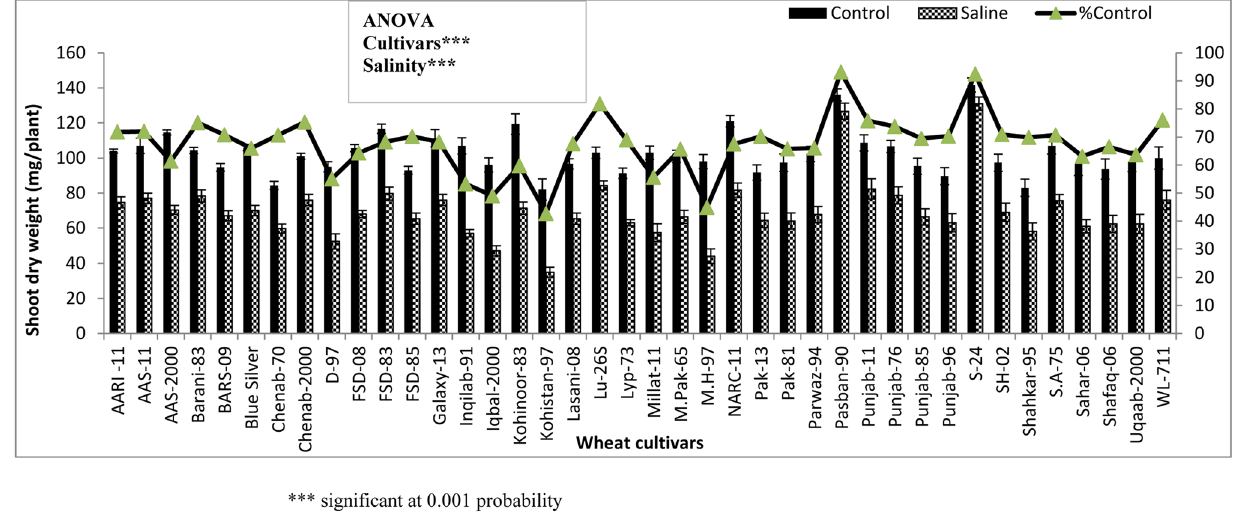
Figure 1. Shoot dry weights of wheat seedlings, when seeds of 40 local wheat cultivars were grown under normal or 150 mM NaCl salinity stress for three weeks. Means are presented on primary vertical axis while percent of control values are presented on secondary vertical